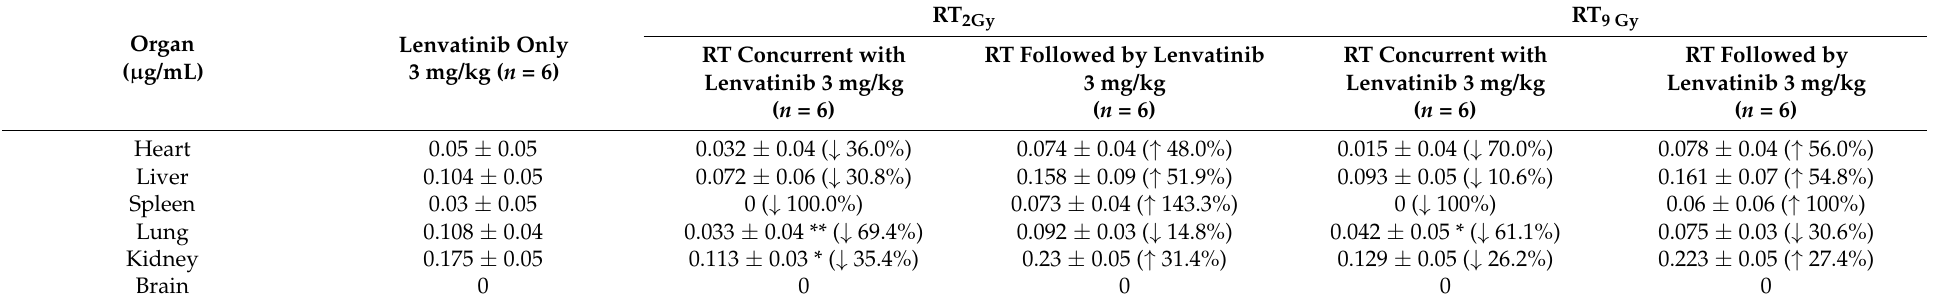
Table 2. Concentrations of lenvatinib in the heart, liver, spleen, lung, kidney, and brain of rats after administration (3 mg/kg, p.o.) with or without